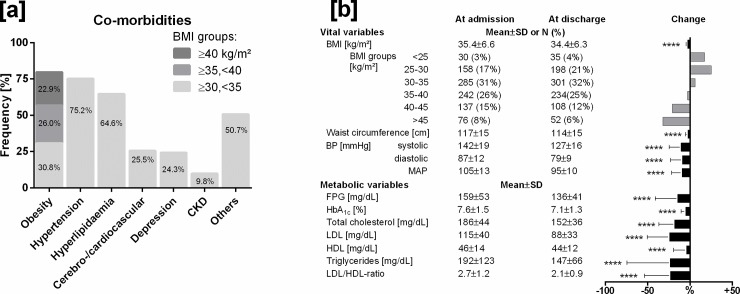
[a] Prevalence of co-morbidities. CKD, chronic kidney disease. [b] Vital and metabolic variables at baseline and their changes at discharge after three weeks. BP, blood pressure; MAP, mean arterial pressure; FPG, fasting plasma glucose. To convert values to mmol/L, multiply by 0.056 (glucose), by 0.026 (total cholesterol, LDL, HDL) and by 0.011 (triglycerides). p-values are derived from paired Student’s t-tests. ****, p<0.0001.